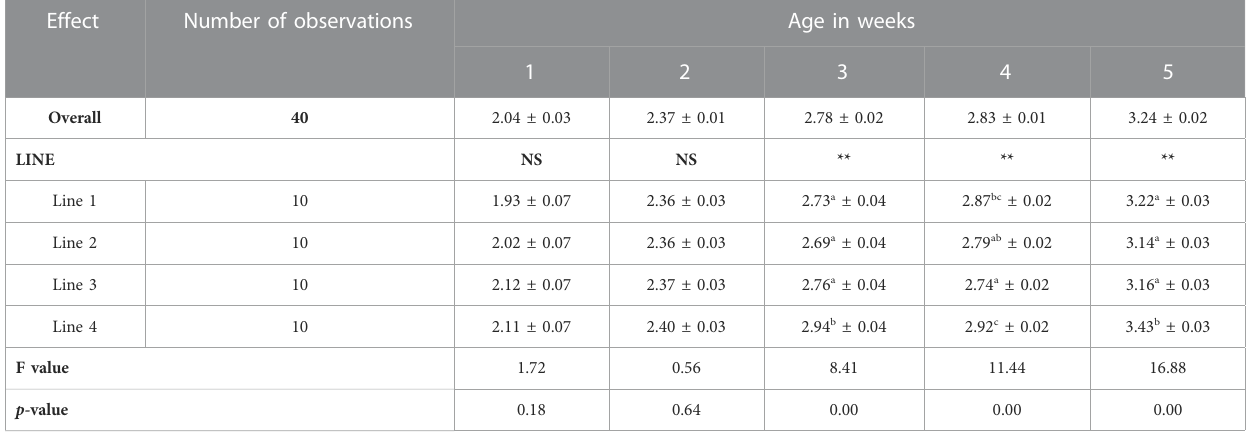
TABLE 2 Means (±S.E.) of cumulative feed conversion ratio of different lines of Japanese quail from fi rst to fi fth week of age.